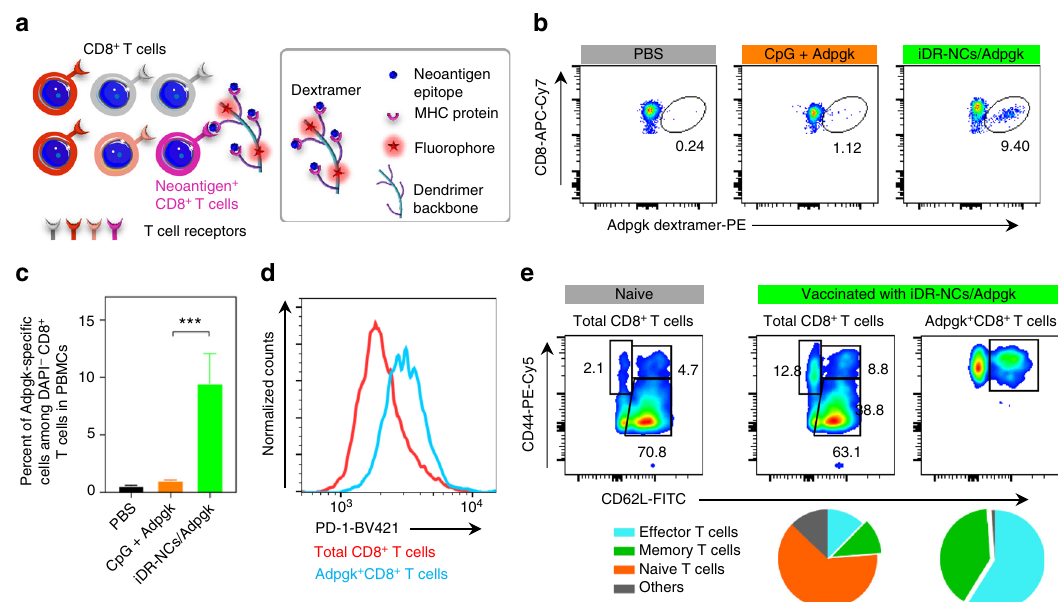
Fig. 7 iDR-NC/neoantigen elicited potent and durable neoantigen-speci fi c T cell responses. C57BL/6 mice were s.c. immunized with CpG/shRNA Stat3 -iDR- NCs/Adpgk (2 nmol CpG equivalents, 17 μ g Adpgk) on day 0 and day 14. a Schematic illustration of dextramer staining to analyze antigen-speci fi c CD8 + T cells. b Representative fl ow cytometry and c quanti fi cation of ASMTNMELM-speci fi c CD8 + T cells among live (DAPI − ) CD8 + cells in PBMCs, as stained using a PE-conjugated ASMTNMELM-H-2D b dextramer on day21. d Flow cytometry showing upregulated PD-1 expression on PBMC Adpgk + CD8 + T cells, relative to total CD8 + T cells, in mice vaccinated with iDR-NC/Adpgk on day21. e Upper: representative fl ow cytometry plots showing CD8 + T cell effector/ effector memory/central memory phenotypes in PBMCs of naive mice and mice vaccinated with iDR-NC/Adpgk on day49; lower: quanti fi cation of the fractions of CD8 T cell populations in mice vaccinated with iDR-NC/Adpgk. iDR-NC/Adpgk induced substantial central memory (CD62L high CD44 + ) CD8 + T cells, especially memory Adpgk + CD8 + T cells compared with age-matched naive mice. (*** p < 0.001; n = 4; one-way ANOVA with Bonferroni post-hoc test). Data represent mean ±